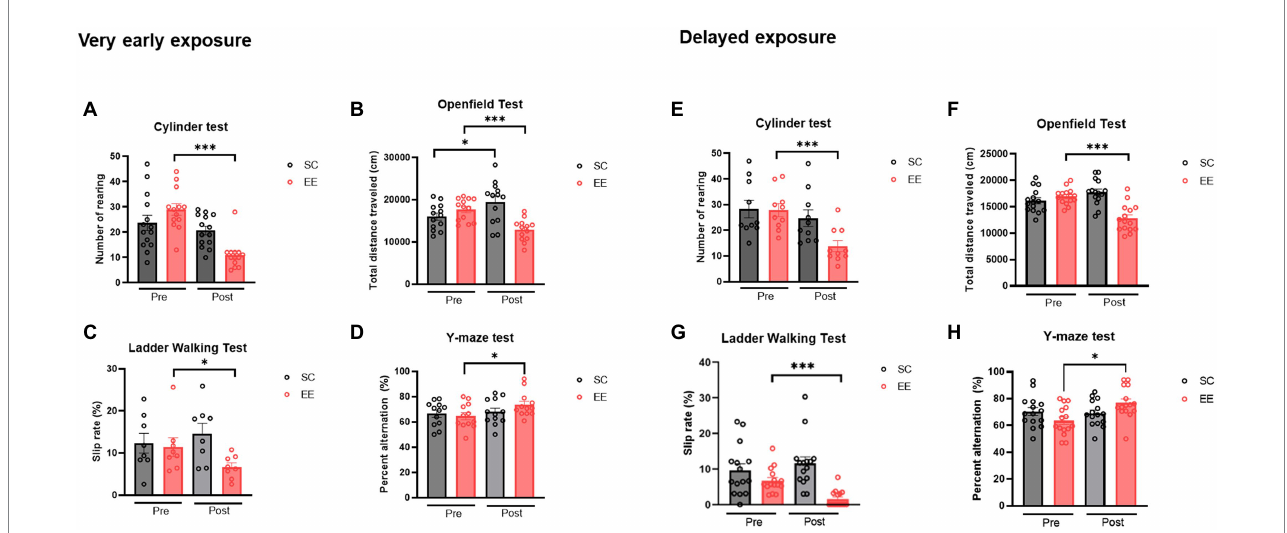
FIGURE 2 Quantitative analysis of the effect of very early and delayed exposure to EE on the neurobehavioral functions in mice after HI brain injury (A–H) . (A) Number of rearings in the cylinder test ( n = 14 per group). (B) Total distance traveled in the open field test ( n = 13 per group). (C) Percentage of total slips in the ladder walking test ( n = 8 per group). (D) Percentage of spontaneous alternations in the Y-maze test ( n = 12 per group). (E–H) Histograms depicting outcomes in the delayed exposure group and its respective control group. (E) Number of rearing in the cylinder test ( n = 15 per group). (F) Total distance traveled in the open field test ( n = 15 per group). (G) Percentage of total slips in the ladder walking test ( n = 15 per group). (H) Percentage of spontaneous alternations in the Y-maze test ( n = 15 per group). All statistical comparisons were performed via Student’s t-tests. Data represented are means ± SEM. * p < 0.05, ** p < 0.01, and *** p < 0.001. EE, environmental enrichment; HI,